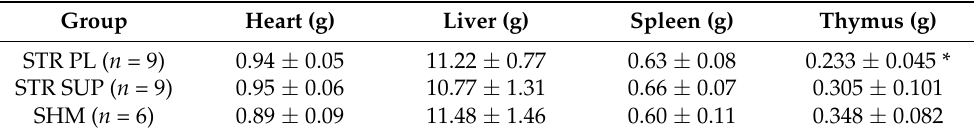
Table 7. Internal organs mass at the end of the experiment in stressed rats.